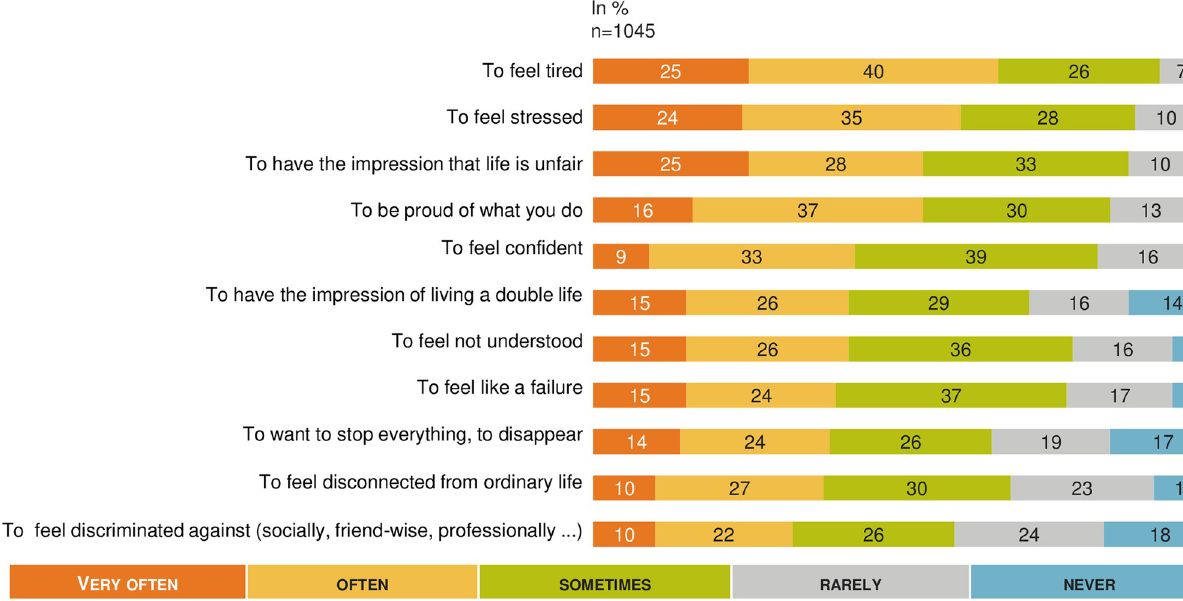
Fig 2. MAR and psychological impact: A French national survey. Percentage of answers to the question “Would you say each of the following happen to you very often, often, sometimes, rarely, or never?” (n = 1 045).